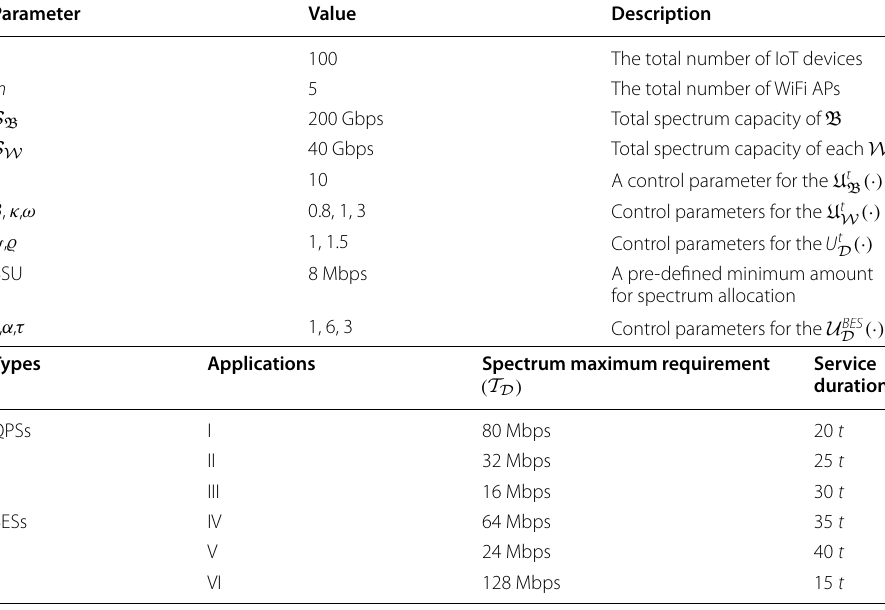
Table 2 System parameters used in the simulation experiments Parameter Value Description 100 The total number of IoT devices The total number of WiFi